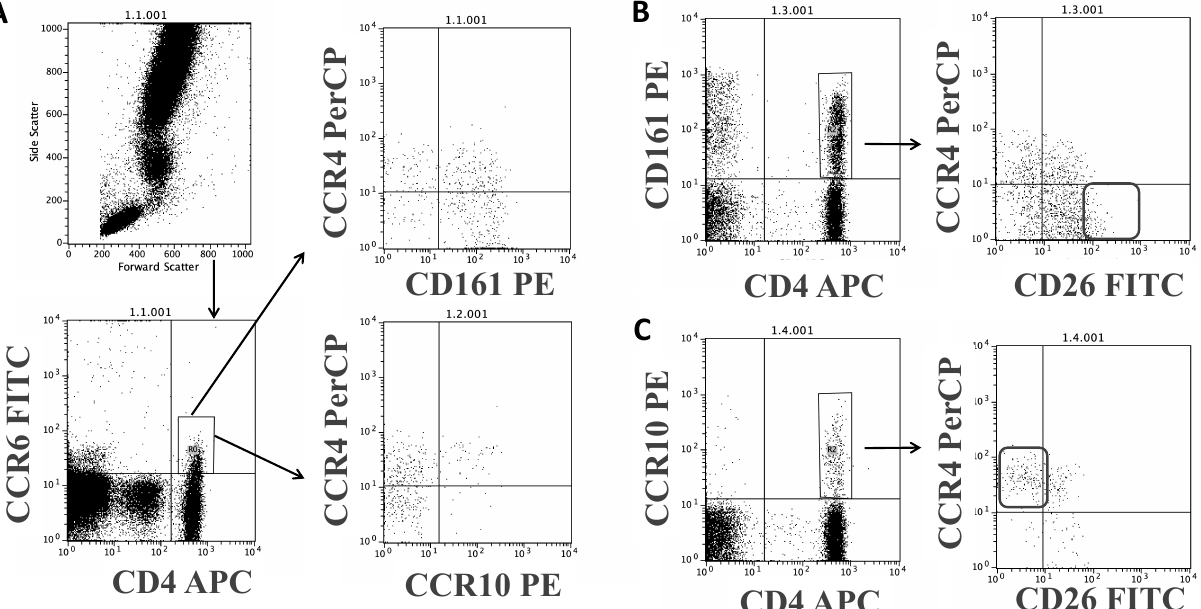
Figure 5. Cell-surface CD26 in T helper 17 and 22 cell subsets defined by CD4, CCR6 (CD196), CD161 and CCR4 (CD194). ( A ) Representative flow cytometry ( n = 4) dot-plots showing lymphocyte gating strategy for CD4, CCR6, and CD161 vs. CCR4 for Th17 cells (above) and CCR10 vs. CCR4 for Th22 cells (below). ( B ) In Th17 cells, the expression of CD26 in the CCR4+ cells is low and the CD26high cells (if any) are CCR4- (the square). ( C ) Most Th22 cells are CCR4+ and CD26- (the square) or